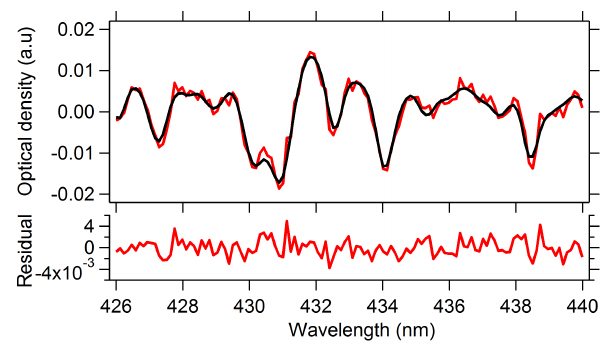
Figure 3. Example of the SRAA dependence of dRSP (filled cir- cles) and I norm (open circles) measured at the solar elevation near 430nm for three SZAs: (red) 66.5 ◦ (7:42LST), (green) 49.0 ◦ (9:17LST), and (blue) 22.0 ◦